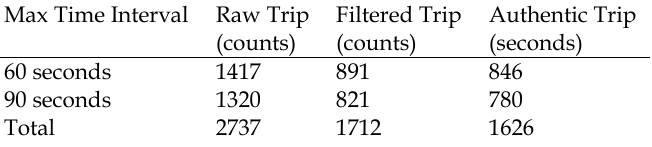
Table 4. Generated Observed